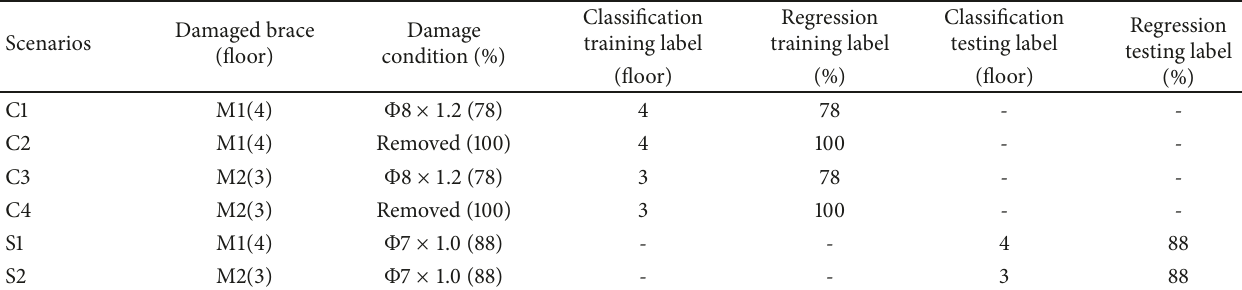
Table 9: Damage scenarios of the shaking table model test.